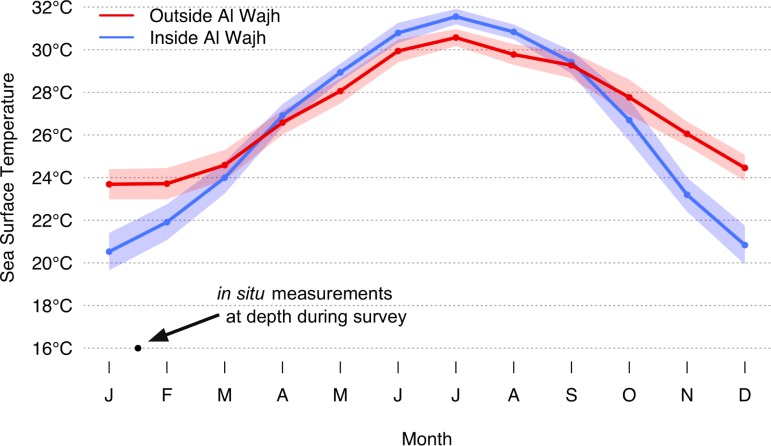
Moderate Resolution Imaging Spectroradiometer (MODIS) monthly sea surface temperature inside and outside Al Wajh Bank, averaged from June 2002 to May 2017.Transparent range indicates standard error. p < 0.05 (paired two-tailed t-test, α = 0.05) between inside and outside for all months except September.